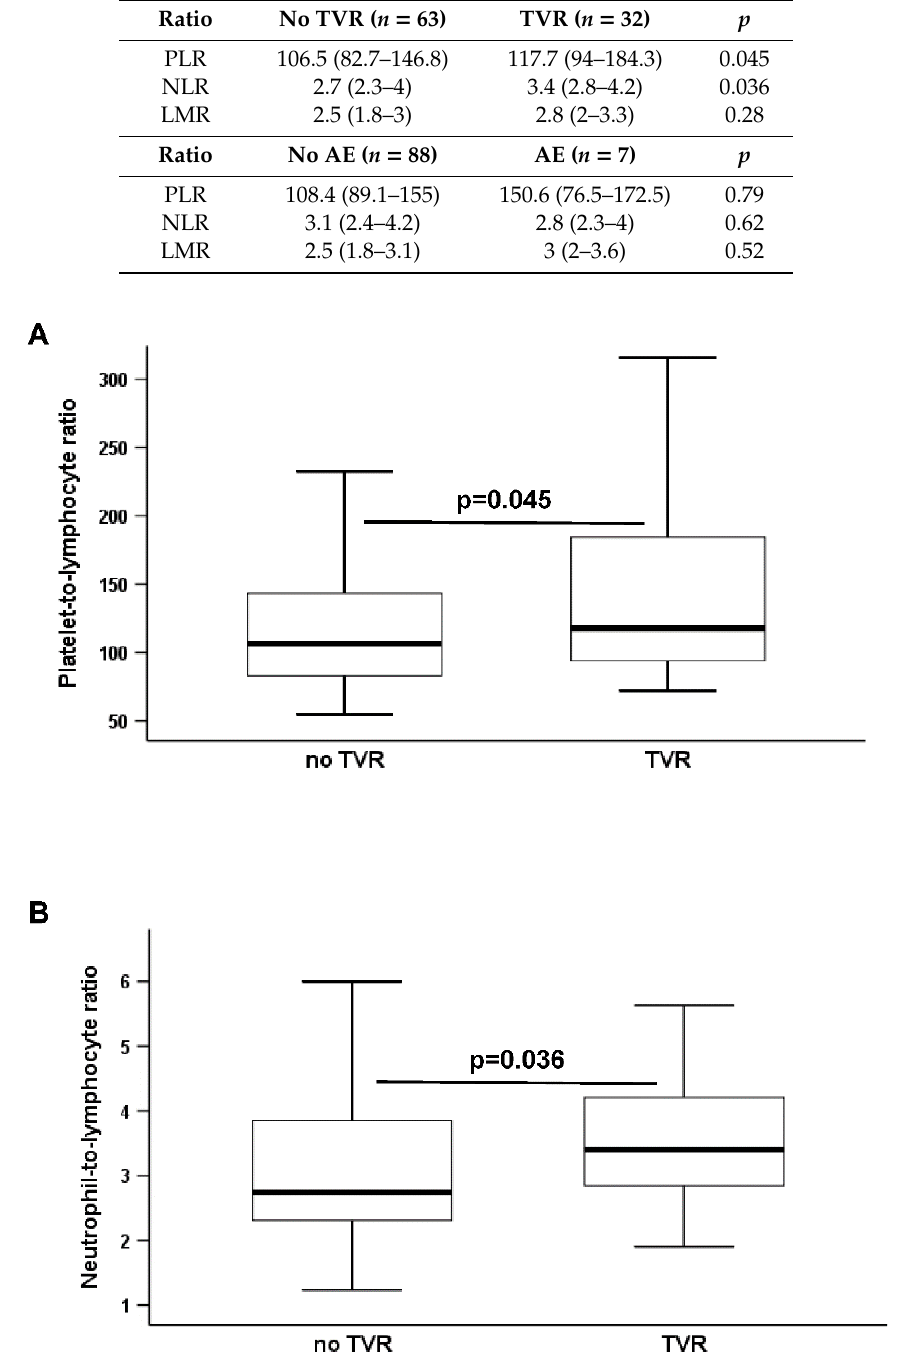
Figure 1. ( A ) Platelet-to-lymphocyte ratio and ( B ) neutrophil-to-lymphocyte ratio in patients without and with the primary endpoint. The boundaries of the box show the lower and upper quartile of data, and the line inside the box represents the median. Whiskers are drawn from the edge of the box to the highest and lowest values that are outside the box but within 1.5 times the box length.